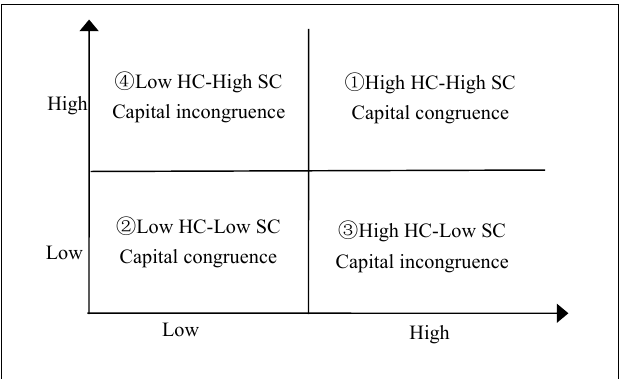
FIGURE 1 | Capital matching